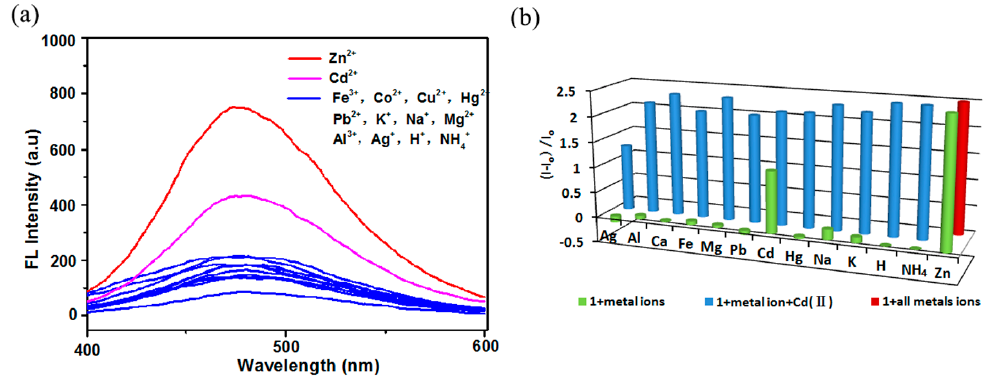
Figure 2. ( a ) The FL intensity of TPE-2triazole-2CD (50 μ M) in DMSO/H 2 O (2/3, v / v ) in the presence of 5 equivalent of different metal ions; ( b ) Fluorescence response of the sensor (50 μ M) to 0.5 equivalent of metal ions (the green bar) and to the mixture of 0.5 equivalent of other metal ions with 0.5 equivalent of Zn 2+ (the blue bar) and the fluorescence response of TPE-2triazole-2CD toward Zn 2+ + all metal ions (the red bar) ( λ ex = 330 nm, λ em = 478 nm).